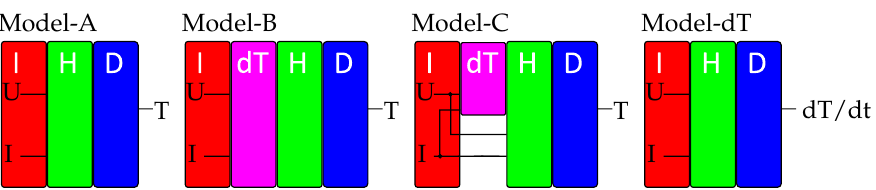
Figure 7. Layer schematic of different models. I-block (red) is the input layer, H-block (green) the hidden layer, D-block (blue) the output layer and dT-block (purple) summarizes the pre trained Model-dT.